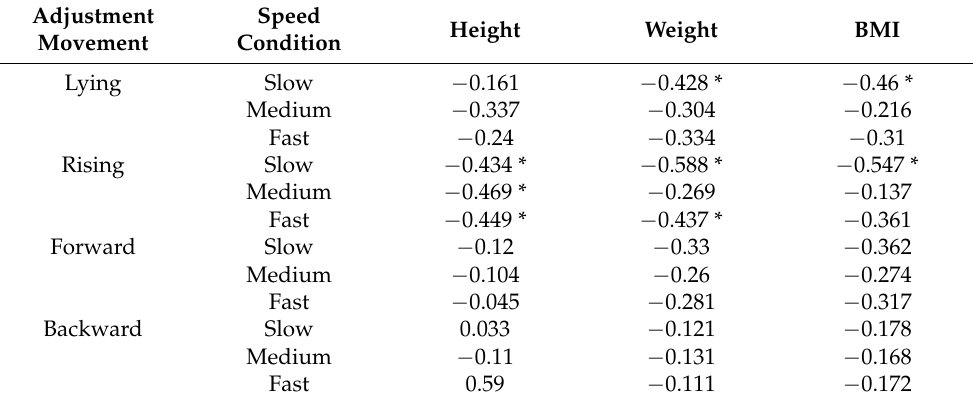
Table 5. Spearman correlation coefficients between overall discomfort ratings and physiological parameters (*, p =